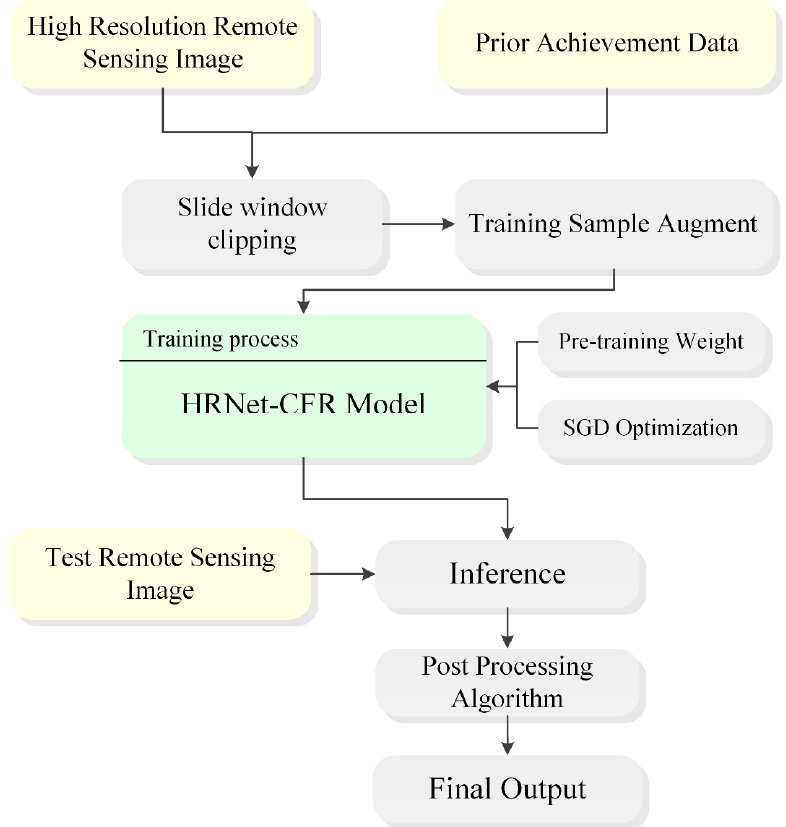
Figure 1. Methodology of cropland extraction with HRNet ‐ CFR.